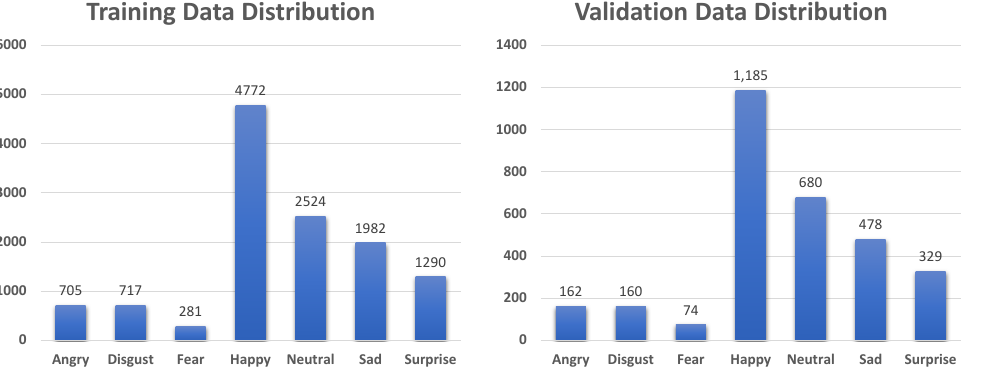
RAF-DB Figure 8. Data distribution for training and validation on RAF-DB dataset